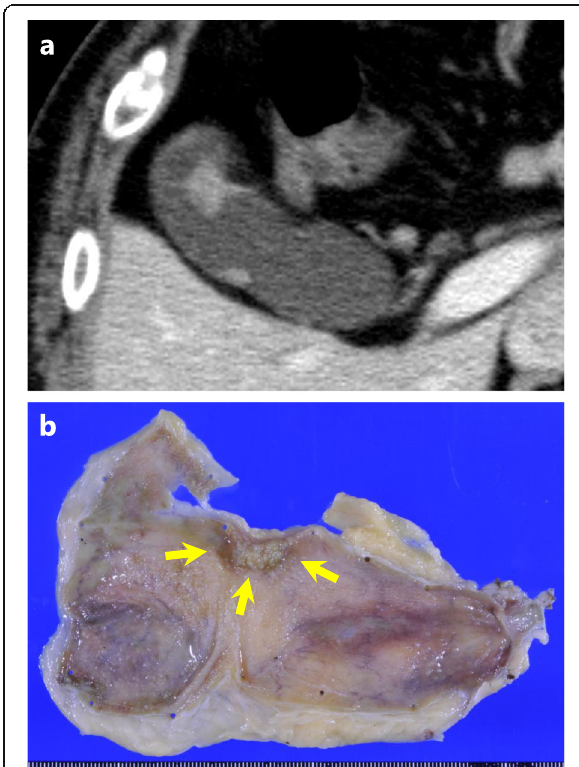
Fig. 1 Images of gallbladder cancer. a Computed tomography revealing a papillary tumor in the gallbladder. b Resected specimen. The yellow arrows indicate a papillary